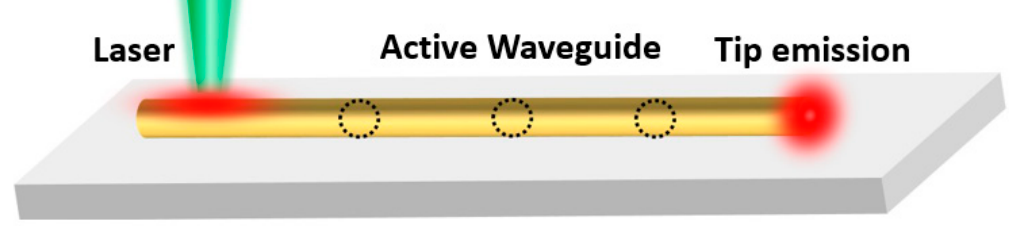
Figure 7. Scheme of waveguide loss coefficient measurement.